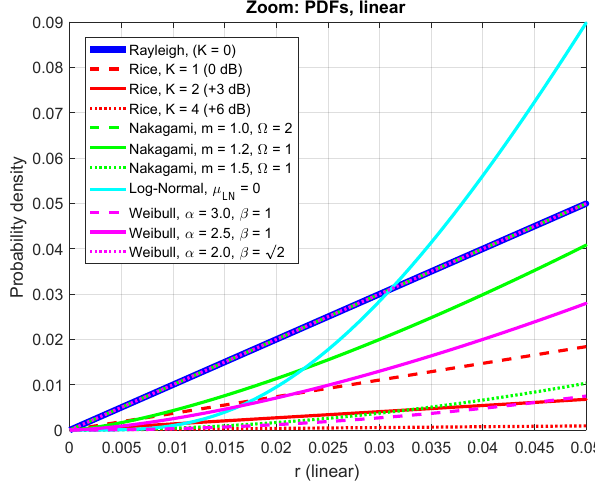
Figure 6. PDFs for Rayleigh, Rician, Nakagami and log-normal fading with different parameters for small amplitudes r . Where ap- plicable, the parameter σ was chosen equal to